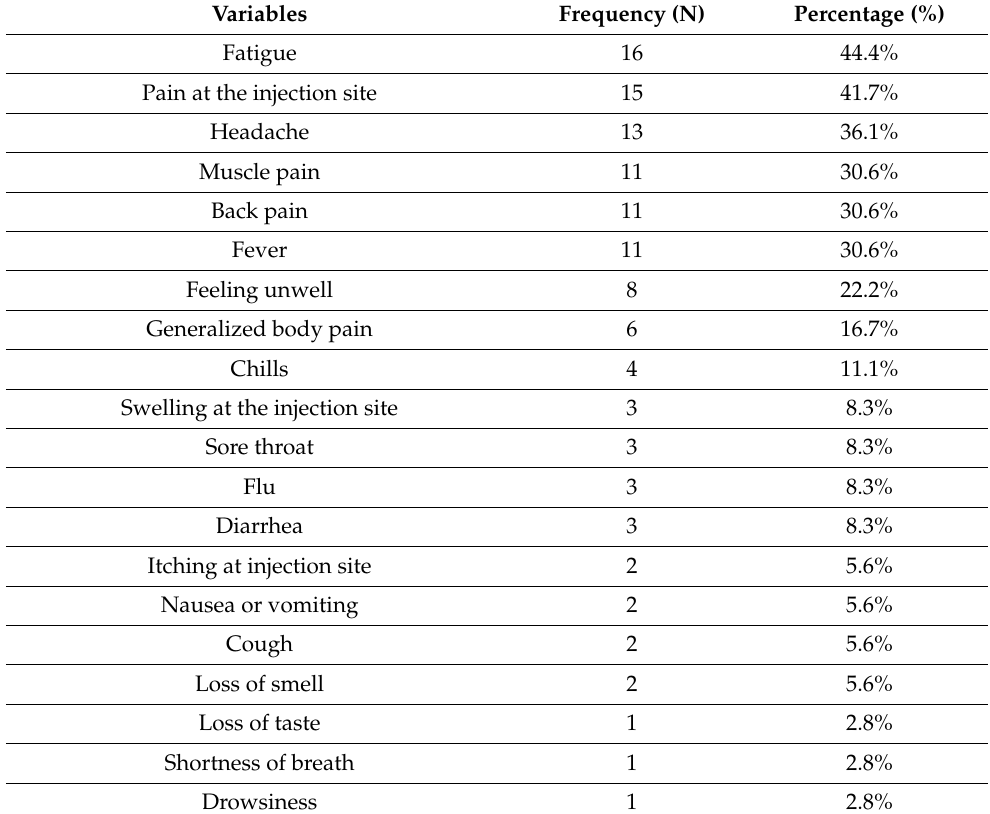
Table 7. Side-effects experienced after booster dose of COVID-19 vaccine (N =